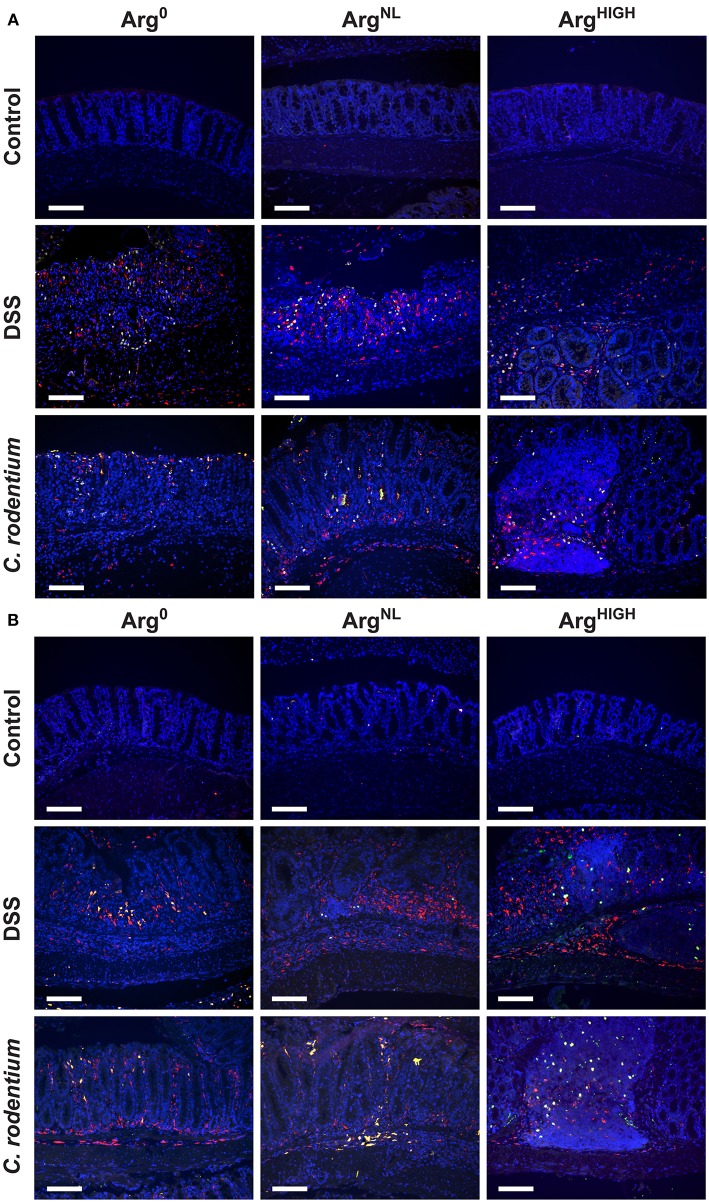
Regulation of NOS2 and arginase-1. NOS2, arginase-1, and CD68 were immunodetected in colonic tissues from C57BL/6 mice ± DSS or C. rodentium ± Arg0, ArgNL, or ArgHIGH diets. In each panel, CD68 is depicted in red, NOS2 (A) or arginase-1 (B) in green, and the nuclei in blue; CD68+NOS2+ and CD68+ARG1+ cells are shown in yellow. The data shown are representative photomicrographs of at least 3 animals per condition. Scale bar, 50 μm.